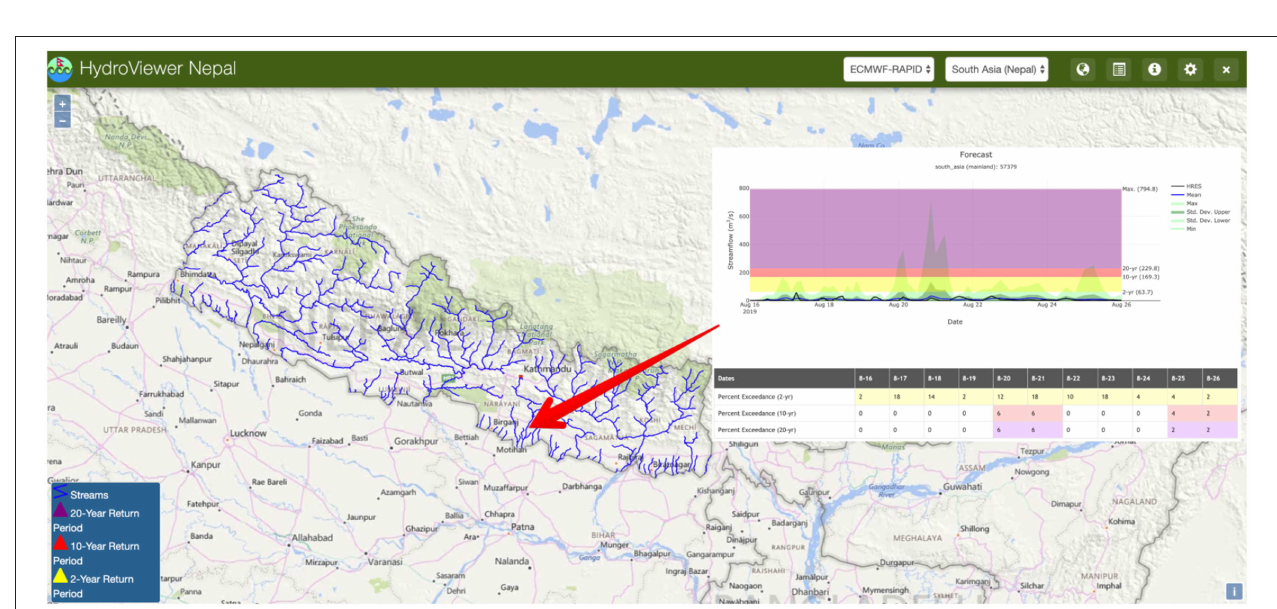
FIGURE 3 | River network and subbasin generation example for the South Asia region.